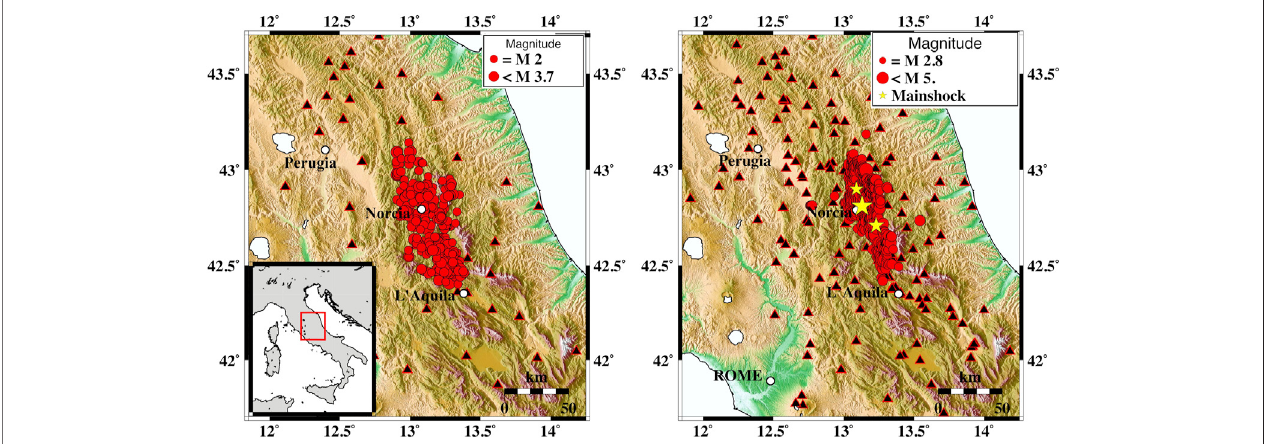
FIGURE 2 | Dataset used for the analysis and the seismic network for the pre-sequence (left) and the Amatrice – Visso – Norcia sequence (right). Black triangles represent the stations; red circles represent the seismic events; stars indicate the main events (Amatrice – Visso – Norcia) of the 2016 – 2017 seismic sequence. The study area is in the lower-left panel in the Italian Peninsula